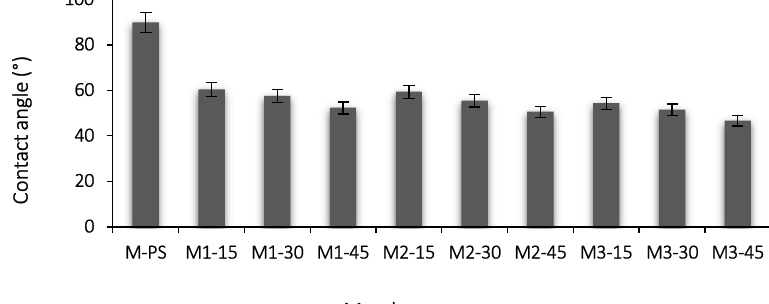
Figure 6. Comparison of PES membrane with and without NCs and SPES in terms of contact angle (n = 5).